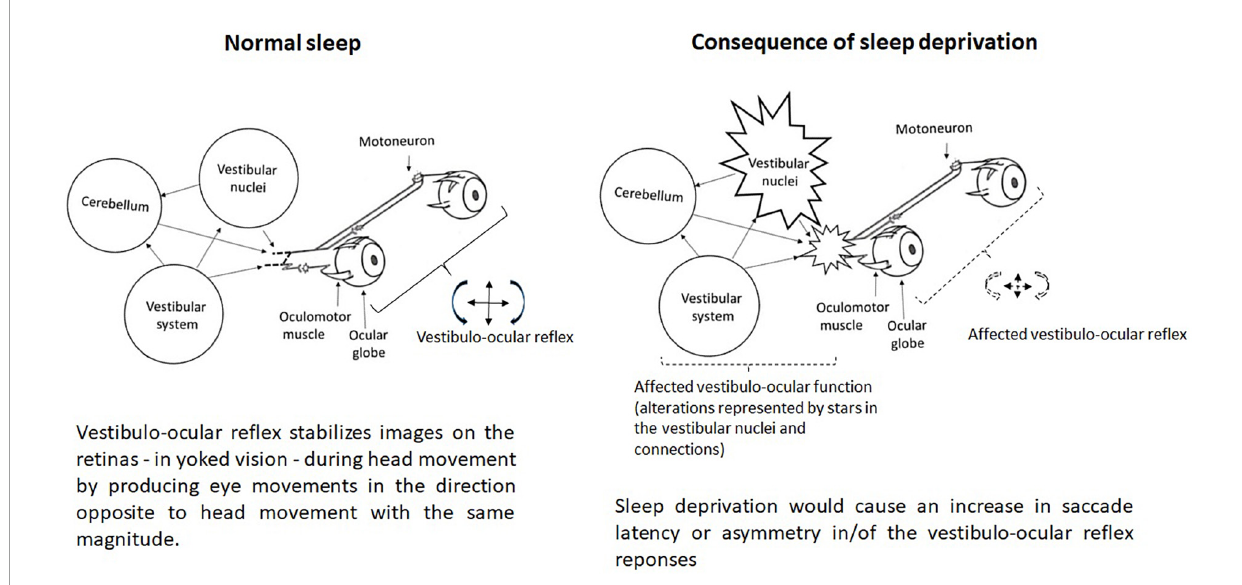
FIGURE2 Representation of the vestibulo-ocular function without and with (consequence) sleep